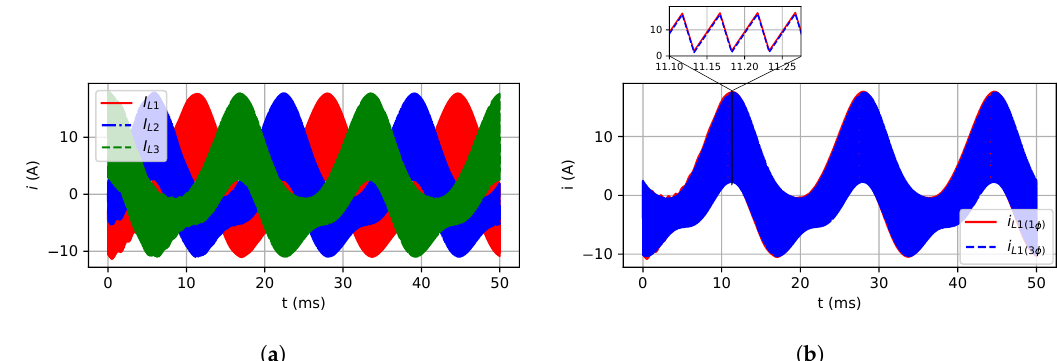
Figure 11. Inductor currents for R load case: ( a ) Three-phase model; ( b ) Single-phase and three-phase (leg 1) models.